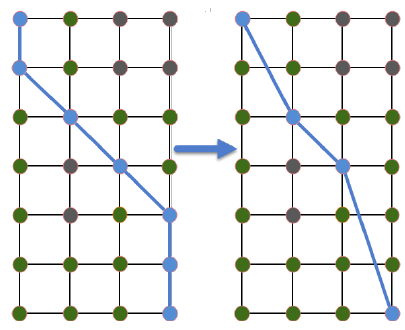
Figure 10. Length changed before and after compression.